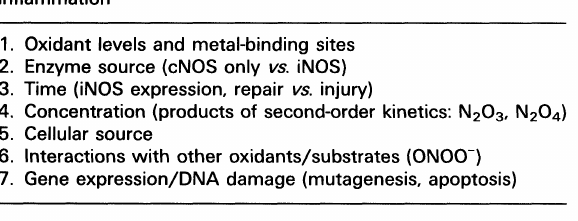
Table 2. Factors influencing the role of nitric oxide in inflammation 1. Oxidant levels and metal-binding sites 2. Enzyme source (cNOS only vs. iNOS) 3. Time (iNOS expression, repair vs. injury) 4. Concentration (products of second-order kinetics: N203, N204) 5. Cellular source 6. Interactions with other oxidants/substrates (ONOO-) 7. Gene expression/DNA damage (mutagenesis,